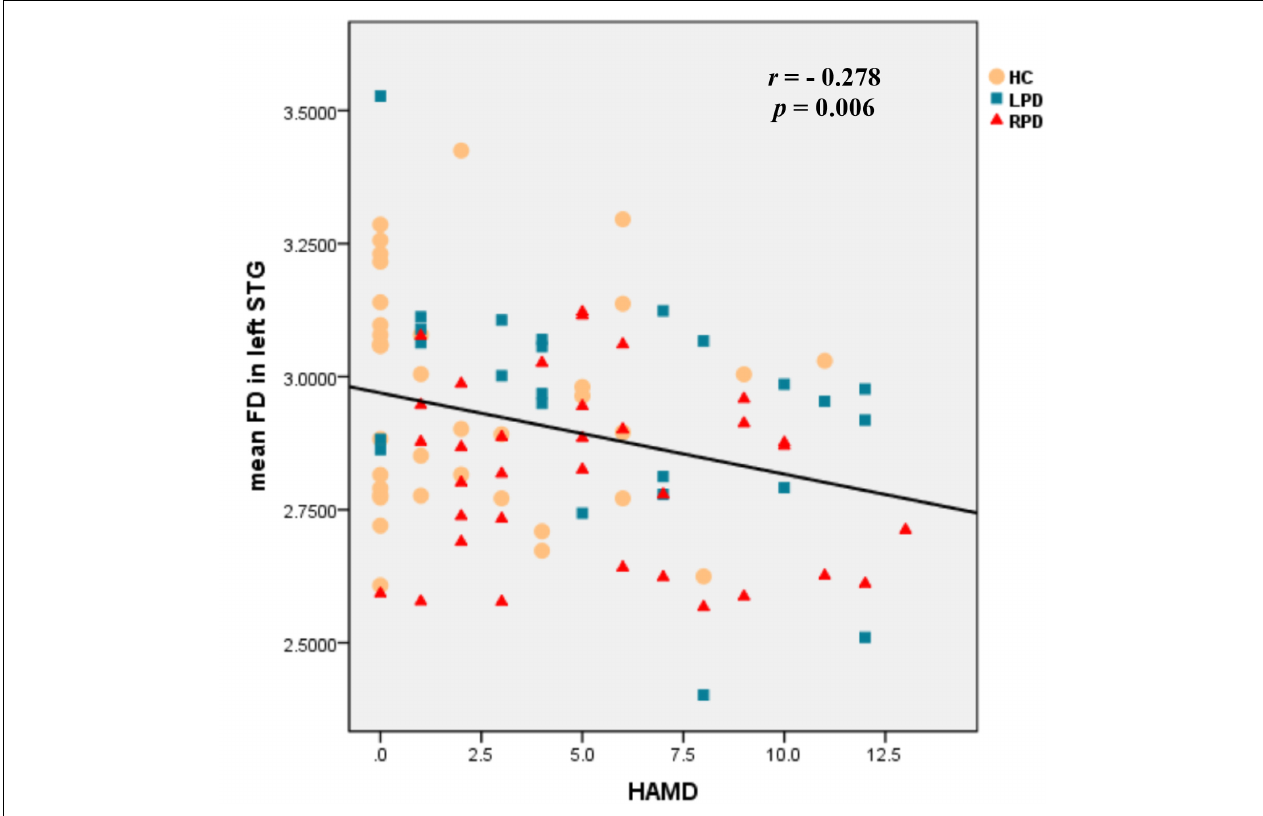
FIGURE 3 | Scatter plots of the mean FD in the left STG negatively correlated with HAMD scores among the three groups ( r = –0.278, p = 0.006, Bonferroni